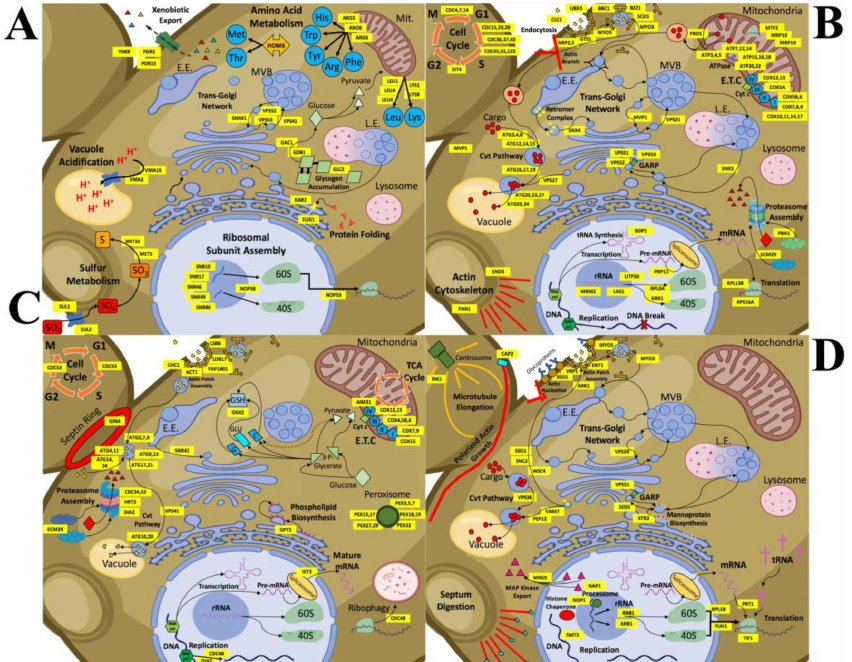
Figure 6. Detailed schematic models representing changes in cellular processes with CdSe/ZnS QDs or InP/ZnS QDs in the budding yeast. Cellular processes are illustrated and labeled with the genes